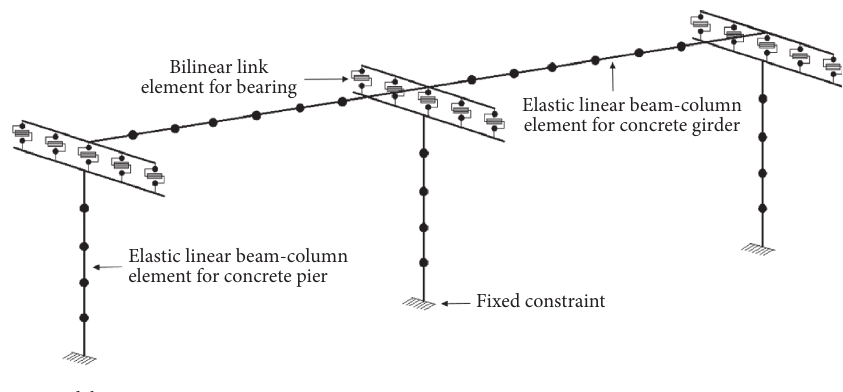
Figure 3: Numerical model of the bridge (girder and deck elements are not shown for clarity).